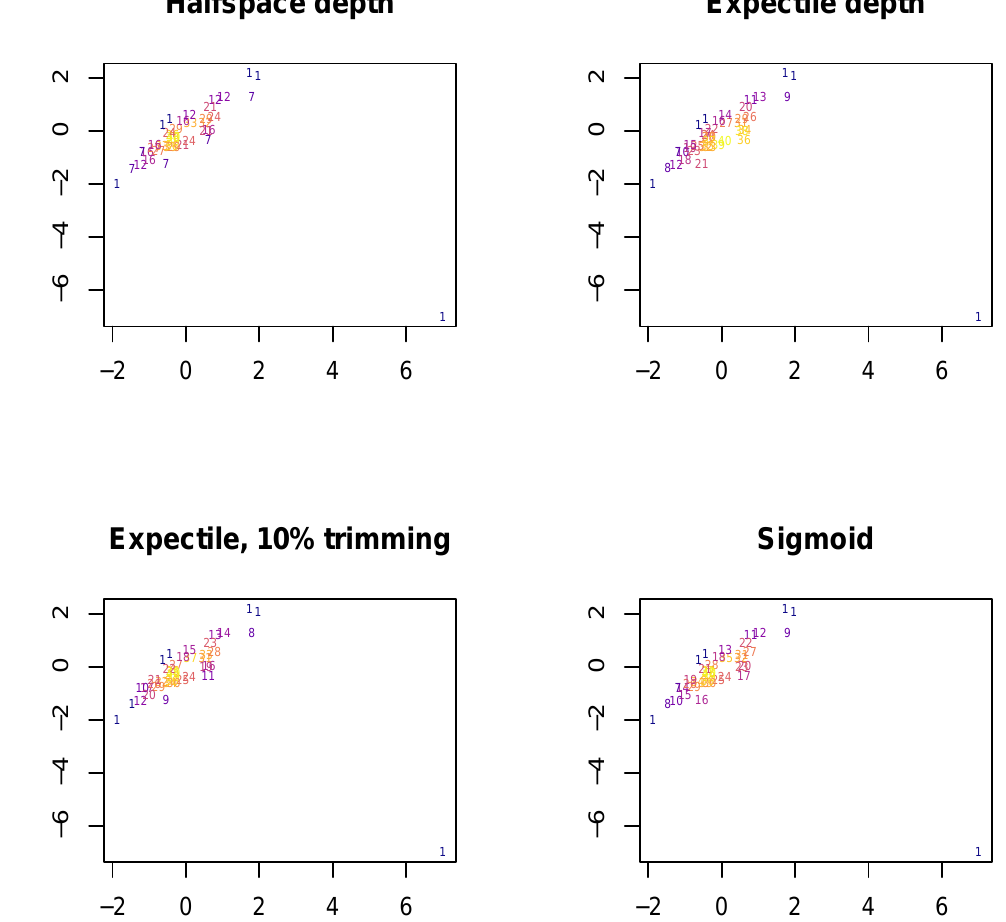
Figure 2. Depth-based ranks for a bivariate normal sample with an outlier with the halfspace depth ( r = 1), the expectile depth ( r = 2), and two distorted expectile depths. The halfspace depth was calculated using the R package ddalpha by Pokotylo et al.